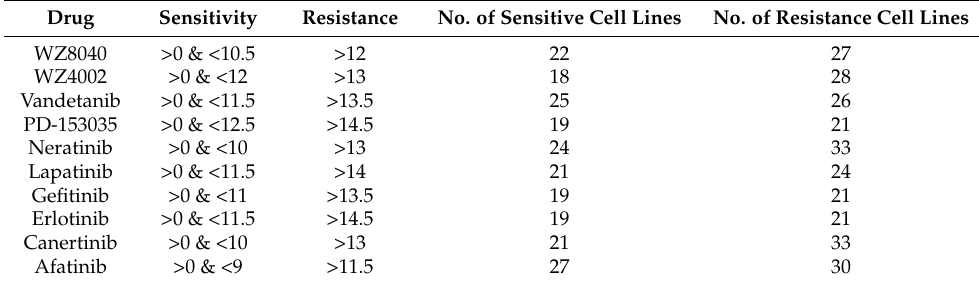
Figure 1. Machine learning flowchart. ( A ) Pharmacogenomic data including lung cancer mRNA expression and EGFR inhibitor drug sensitive data were introduced. These data were from CCLE and CTRP databases, respectively. ( B ) The prediction models of EGFR inhibitor-response genes were constructed based on group lasso algorithm. ( C ) The gene sets associated with each of the 10 EGFR inhibitor responses were predicted. ( D ) Using lasso model to predict methylation sites related with EGFR inhibitor sensitivity. Table 1. Classification conditions of EGFR inhibitor